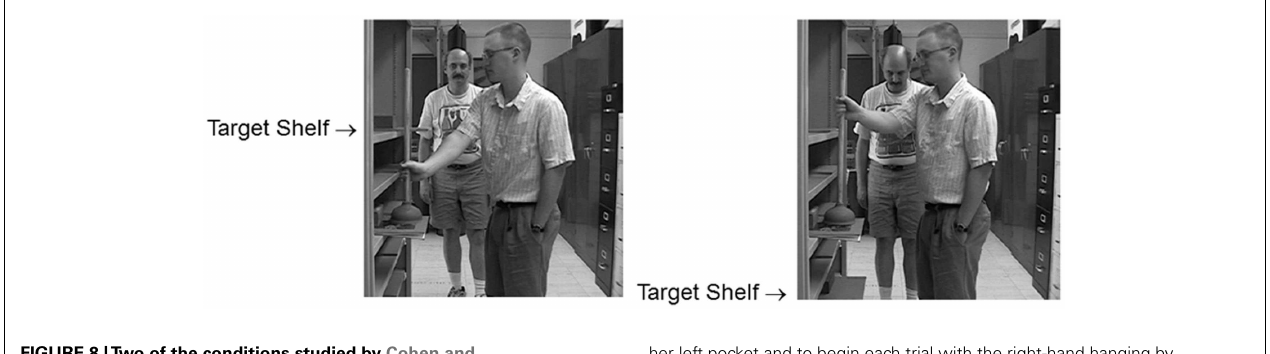
FIGURE 8 |Two of the conditions studied by Cohen and Rosenbaum (2004) in their demonstration of the grasp height effect .The plunger occupies the same starting position in both conditions shown here (and in all five target-height conditions tested). Each participant was instructed to keep his or her left hand in his or